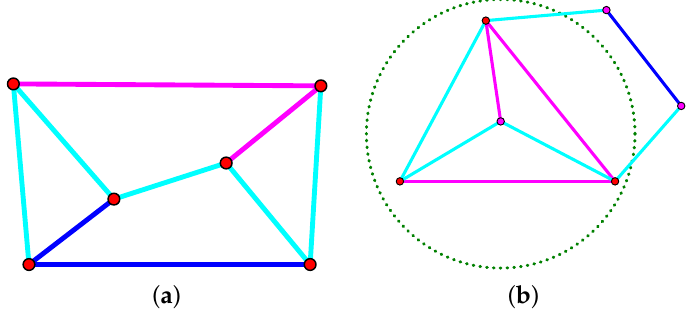
Figure 4. A graph is isostatic in R 2 if and only if the edges can be decomposed into 3 trees, exactly 2 meeting at each vertex (called 3 Tree 2 for short) Figure ( a ). The tree decomposition is proper if no non-trivial subtrees of distinct trees have the same span [47]). Failure is illustrated in Figure ( b ) which is not proper—the subgraph in the circle is covered by two trees (hence has